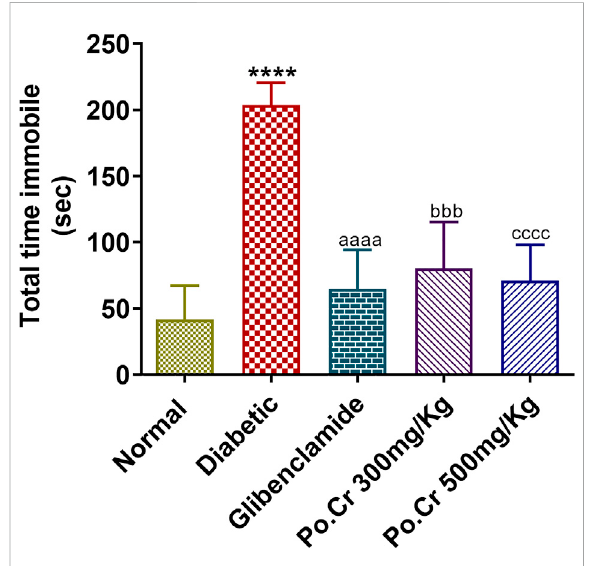
FIGURE 6 Anti-depressant effects of Po.Cr in the forced swim test (FST) of alloxan-induced diabetic rats, showing total time immobile (in sec) for the different groups. Group II (diabetic control) was comparedtoGroupI(normalcontrol),whereasallthetreated groups (Groups III [glibenclamide] to V [Po.Cr]) were compared with Group II (diabetic control). ANOVA (two-way) and the multiple comparison Dunnett ’ s test were applied, and the data values are mean ± SEM. * p < 0.05 indicates comparison of the diabetic control (Group II) to the normal control (Group I), while a p < 0.05, b p < 0.05, and c p < 0.05 indicates comparison of glibenclamide (Group III); Po.Cr, 300 mg/kg (GroupIV); and Po.Cr, 500 mg/kg (Group V) versus the diabetic control group, respectively.